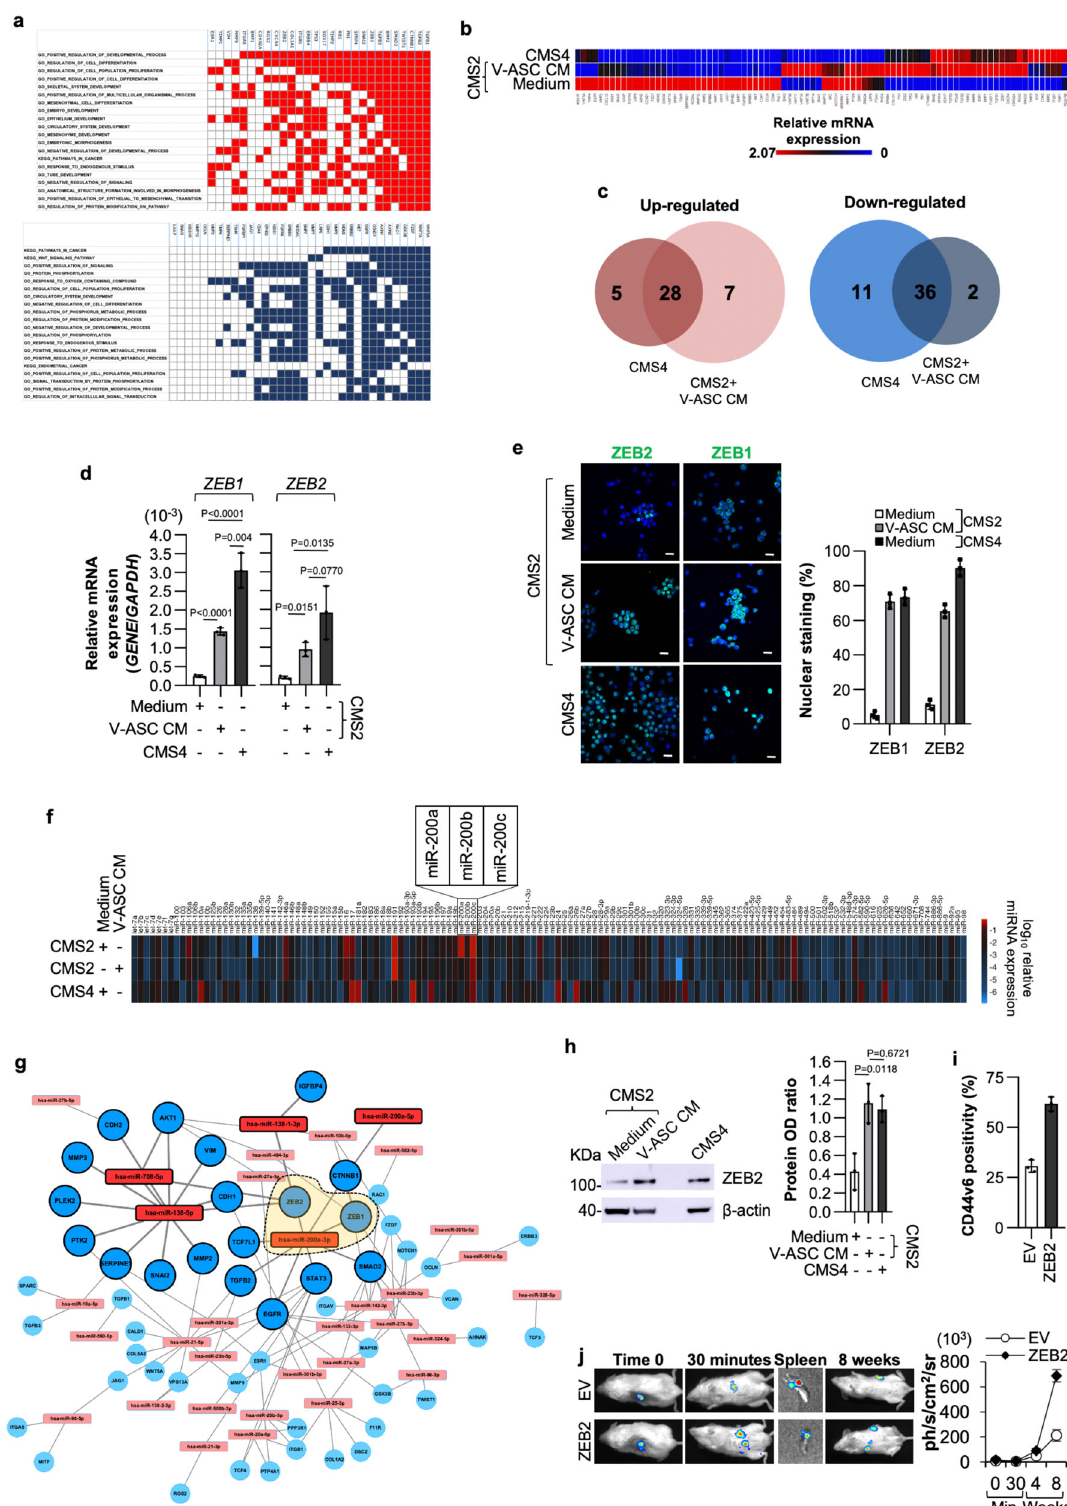
number of cells expressing CD44v6, the cell population able to colonize the liver and produce CRC metastases 43 . CD44v6 + cells produce NGF and NFT3, which in turn recruit ASCs promoting a paracrine loop that increase the tumor cell aggressiveness. The presence of adipose tissue in liver CRC metastasis is likely due to recruitment from disseminated CD44v6 cells and the migration capacity of V-ASCs in patients affected by obesity. In parallel with